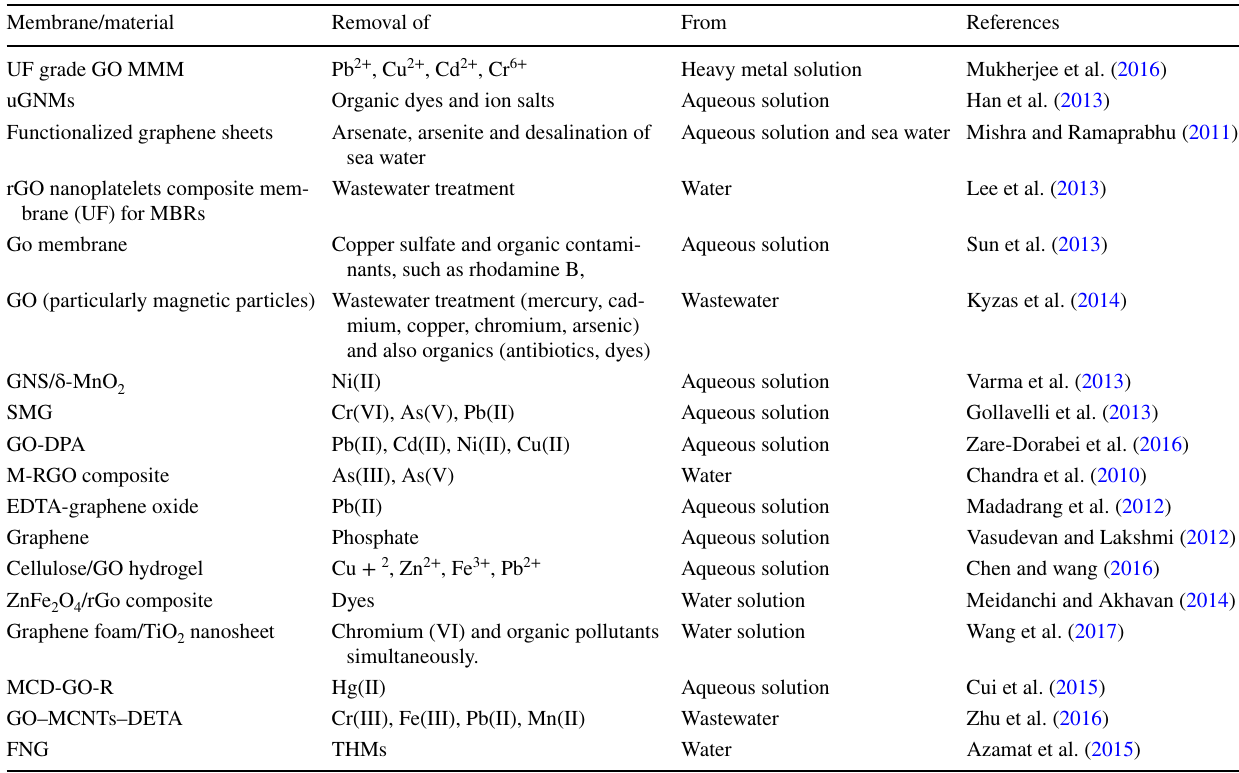
Table 12 Summary of graphene related membrane/material used for waste water treatment Membrane/material